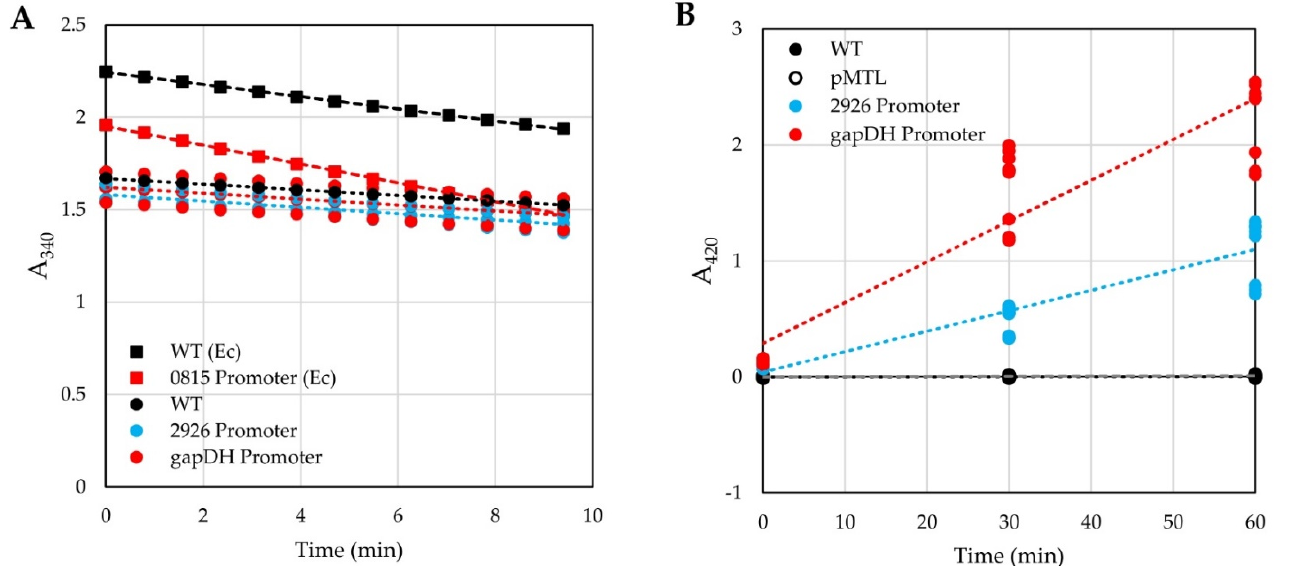
Figure 1. A reporter expression study utilizing two different reporters in H. modesticaldum and E. coli . Alcohol dehydrogenase ( A ) and β -gal ( B ) activities in extracts from unmodified (WT) and H. modesticaldum transformed with empty vector (pMTL) or expression plasmids using the 2926 or gapDH promoters. As a positive control, assays using extracts from E. coli (Ec) cells that were either unmodified (WT) or transformed with a vector using the 0815 promoter are included for comparison in panel ( A ). Each point represents a single technical or biological replicate. E. coli and WT H. modesticaldum controls in ( A ) are displayed with a single replicate ( n = 1), while 2926 and gapDH samples display each individual replicate ( n = 9); all samples in ( B ) are displayed with each individual replicate ( n = 9). Dotted or dashed lines represent the trendline generated for each dataset.